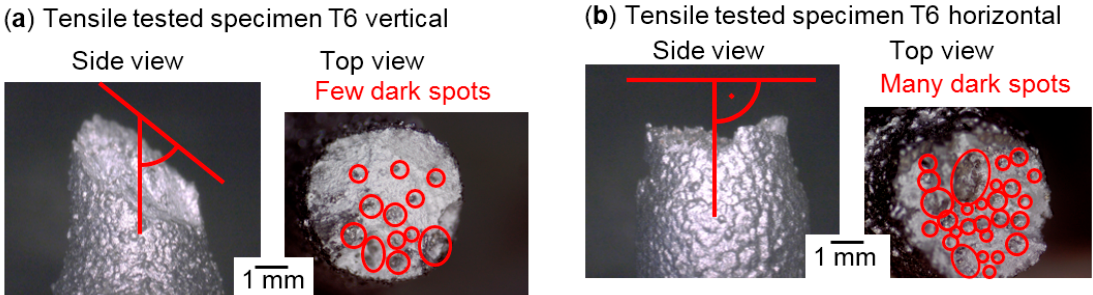
Figure 6. Side and top views in reflected light microscopy of fracture surfaces ( a ) inclined and ( b ) orthogonal to the pulling direction. For larger magnifications of dark spots, see Figures 7 and 8.